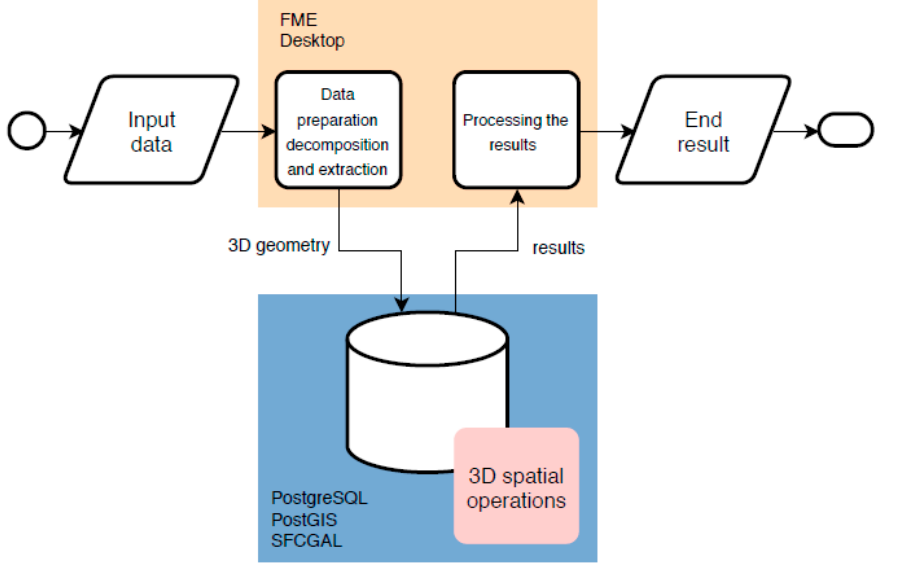
Figure 1. The concept of ETL-based data integration and 3D analytics.